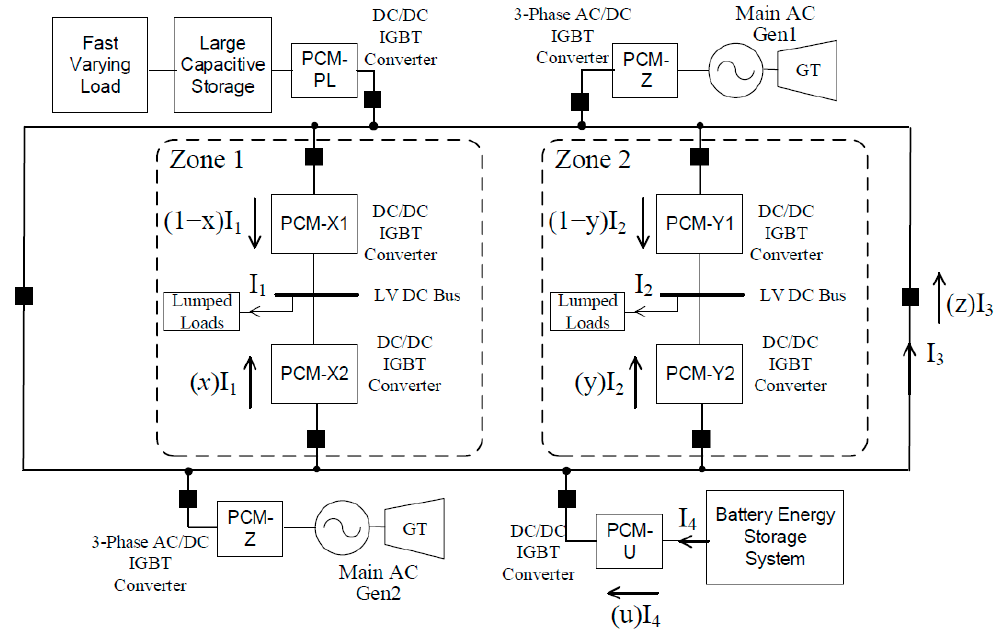
Figure 3. The architecture and electrical model of the notional shipboard microgrid.